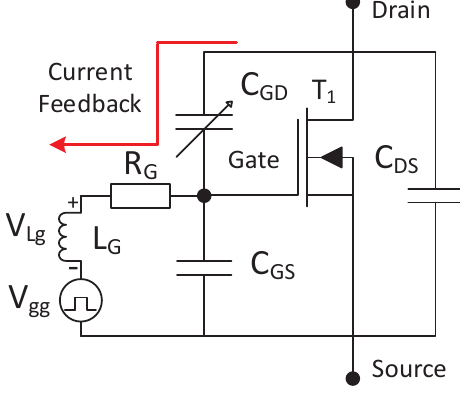
Figure 7. The current feedback process in phase